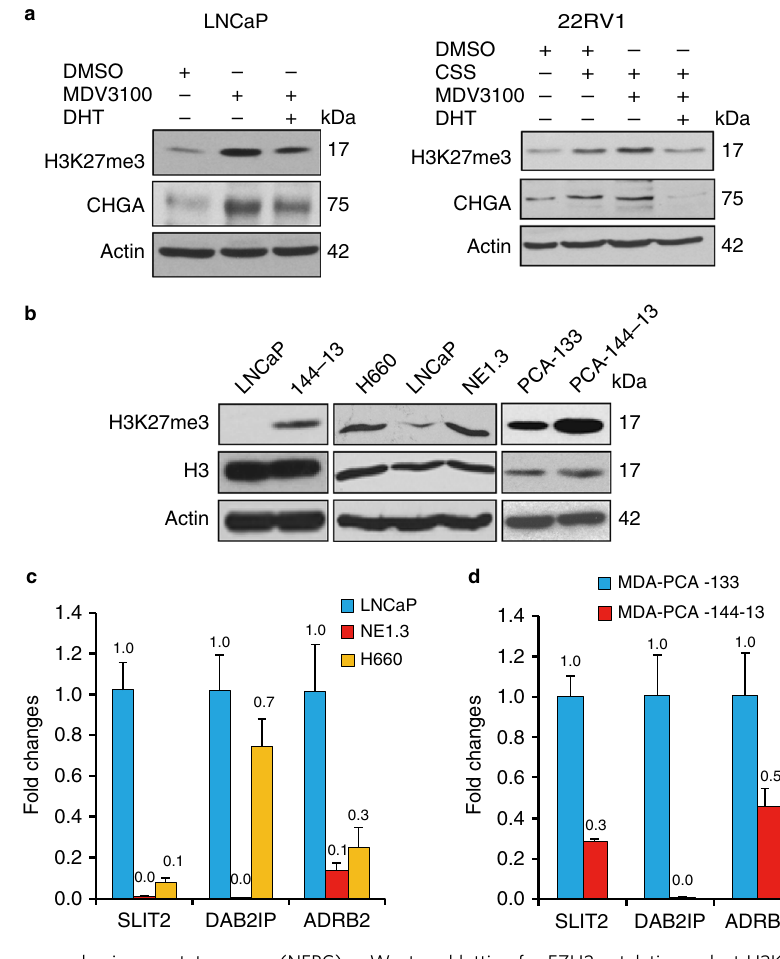
Fig. 2 EZH2 is activated in neuroendocrine prostate cancer (NEPC). a Western blotting for EZH2 catalytic product H3K27me3 level and NE marker CHGA in LNCaP and 22Rv1 cells treated with either CSS or 10 μ M MDV3100 for 72 h, without or with 5 nM DHT in the last 24 h. b Higher levels of H3K27me3 marks in NEPC NE1.3, NCI-H660, and 144-13 cells, as compared to LNCaP cells. H3K27me3 levels were also examined in patient-derived xenograft (PDX) NEPC MDA-PCA-144-13 tumor and adenocarcinoma MDA-PCA-133 tumor. Beta actin and total histone 3 (H3) were also examined as loading controls. c , d Downregulation of known EZH2 targets, SLIT2, DAB2IP, and ADRB2 in c NEPC NE1.3 and NCI-H660 cells as compared to LNCaP cells; and in d NEPC PDX tumor MDA-PCA-144-13 as compared to adenocarcinoma PDX tumor MDA-PCA-133. Y -axis shows relative fold changes in mRNA expression, normalized to GAPDH. Error bars in PCR results represent standard deviation (s.d.) of triplicate